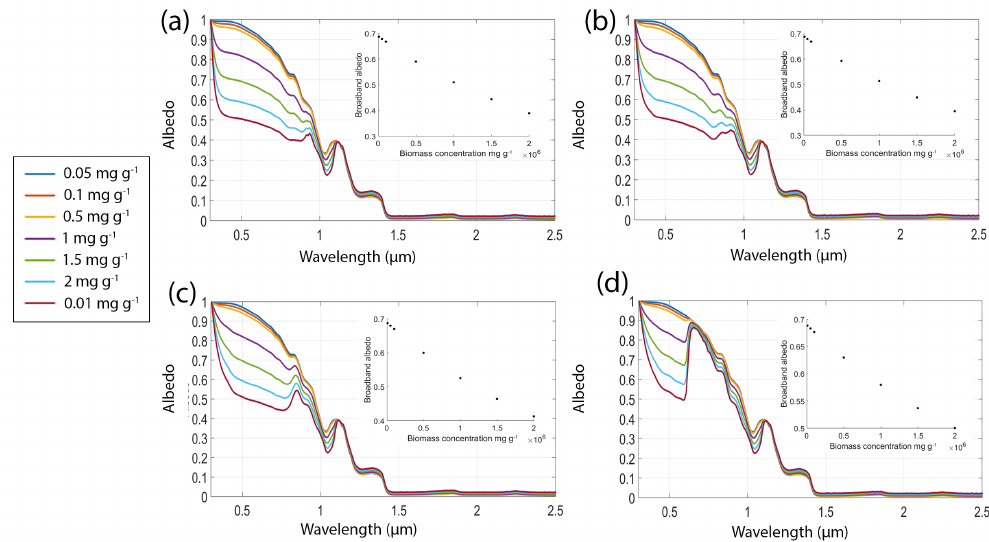
Figure 2. Spectral albedo of snow (grain radius 1500µm) with equal biomass loading of algal cells with varying pigmentation. In all four simulations, chlorophyll a is 1.5% total cell dry weight. In (a) primary and secondary carotenoids are 10% dry weight each. In (b) primary and second carotenoids is 5% dry weight each. In (c) primary and secondary carotenoids are 1% dry weight each. In (d) no carotenoids are present and the cell contains chlorophyll only. In all simulations the solar zenith was 60 ◦ . The legend applies to all four subplots. Inset plots show broadband albedo against biomass concentration for each pigment